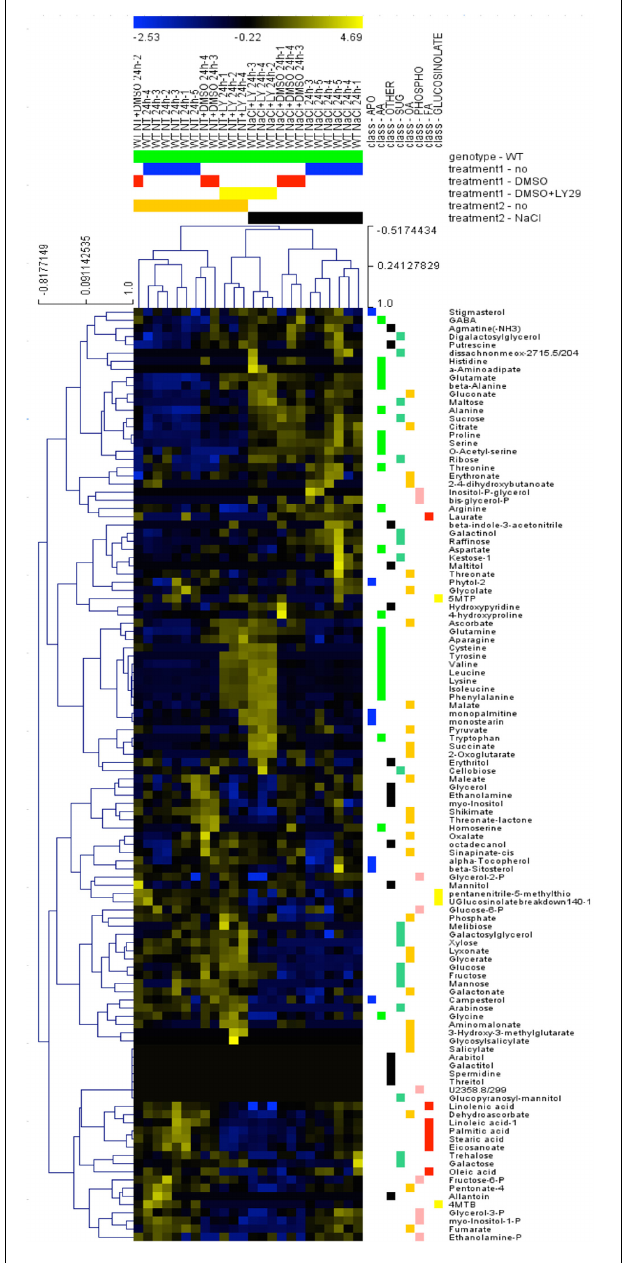
FIGURE 6 | Hierarchic clustering of metabolite changes in WT seedlings subjected to NaCl and LY29002. Metabolite relative content was investigated in 12-days-old Arabidopsis wild-type seedlings treated during 24h as explained in Materials and Methods and analyzed using hierarchic clustering tool (MEV4.0). The color scale shows the concentration ratios in log2.